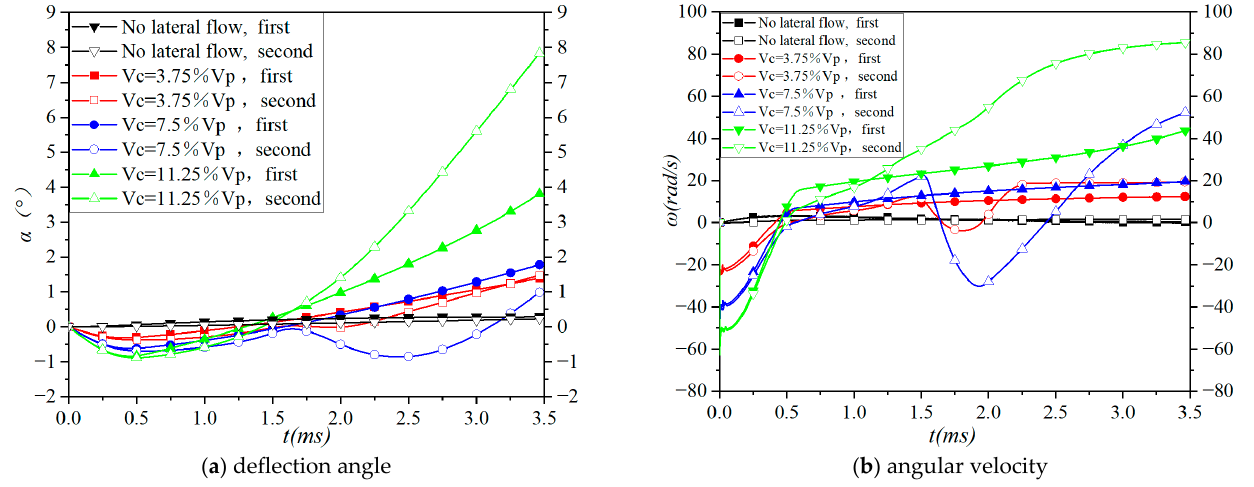
Figure 20. Change in the deflection angle α and the angular velocity with the time under different conditions.